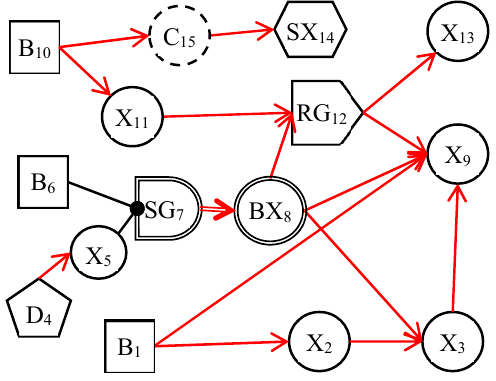
Figure 1. An example of DUCG.